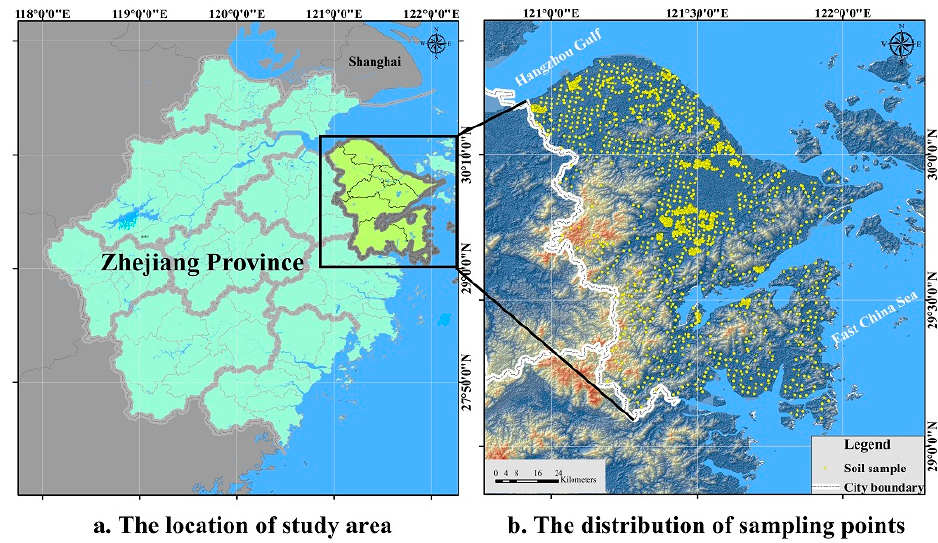
Figure 1. Maps showing the location of the study area ( a ) and the distribution of sampling points ( b ).